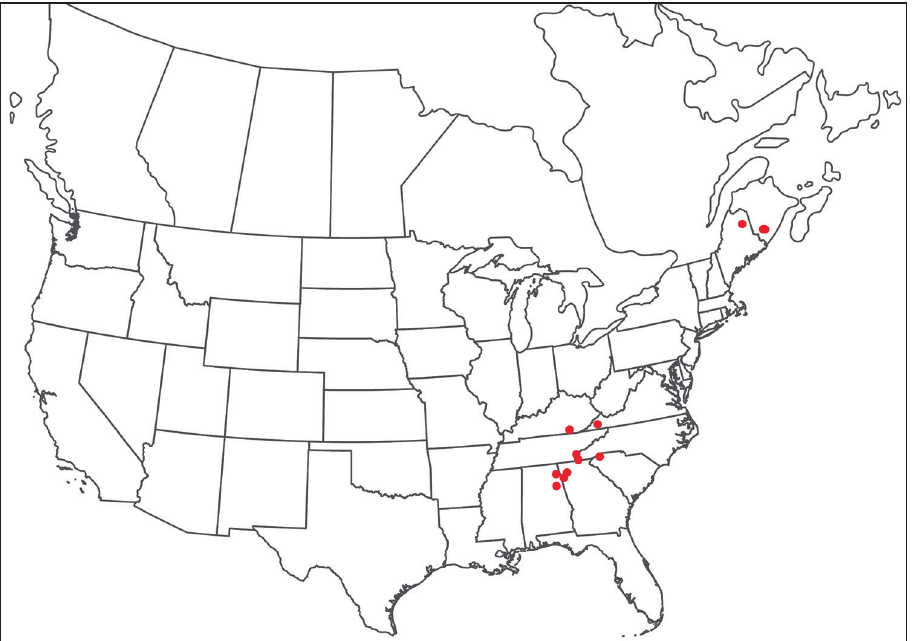
Figure 90. Torrenticola gorti sp. n.